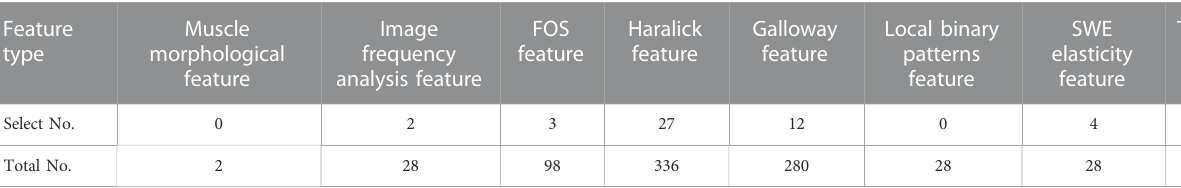
TABLE 4 Speci fi c number of features in the optimal feature set.